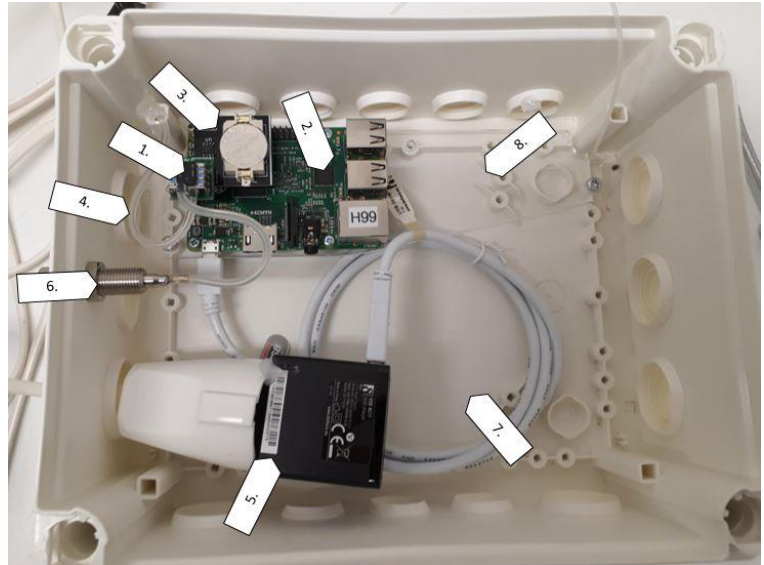
Figure 1. The air pressure difference measurement unit inside an installation box. 1. Differential pressure transmitter (Honeywell TruStability). 2. Raspberry Pi 2 model B. 3. Clock timer. 4. Flexible